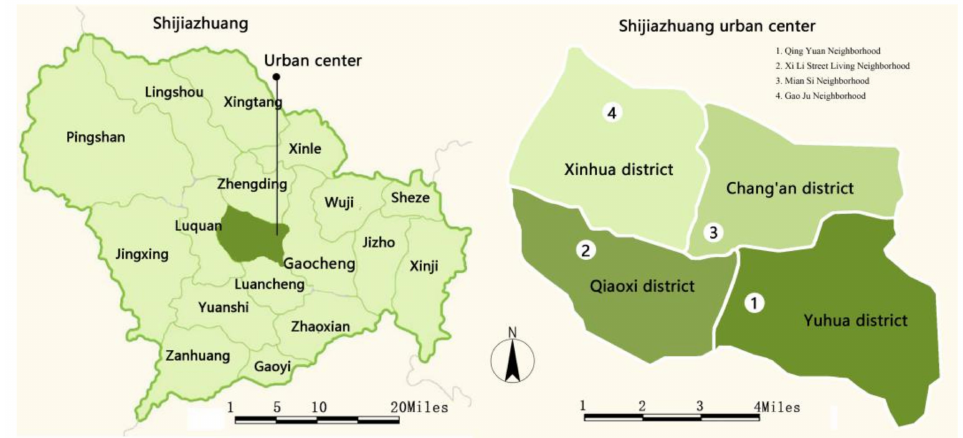
Figure 3. Selected old residential neighborhoods as study sites in